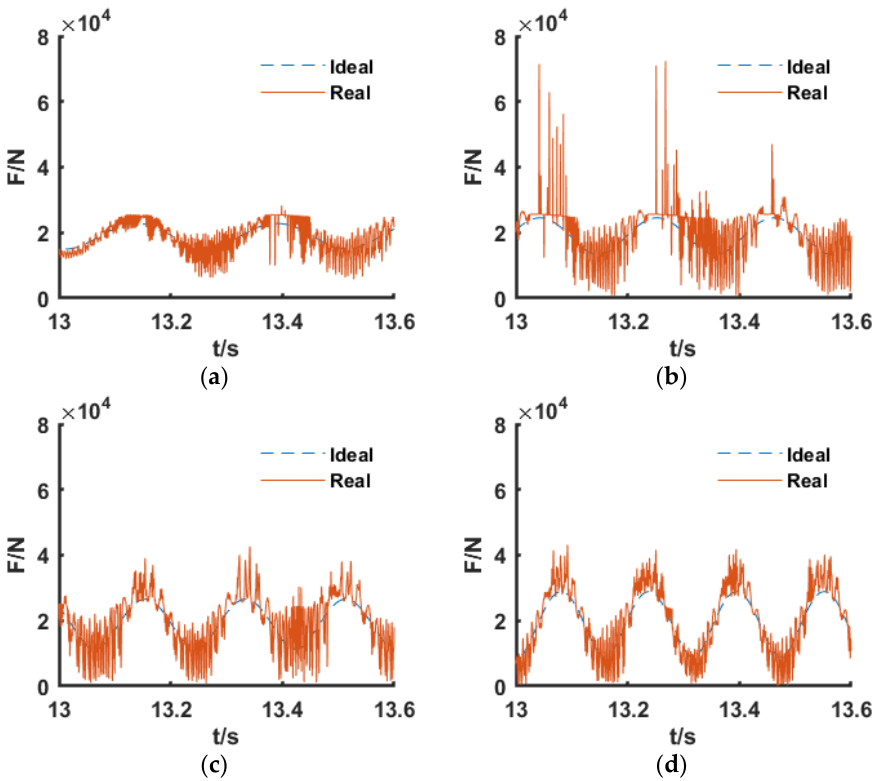
Figure 9. Vibration force on the foundation at different driving speeds. ( a ) 𝜔 = 25 . ( b ) 𝜔 = 30 . ( c ) 𝜔 = 35 . ( d ) 𝜔 = 40 .